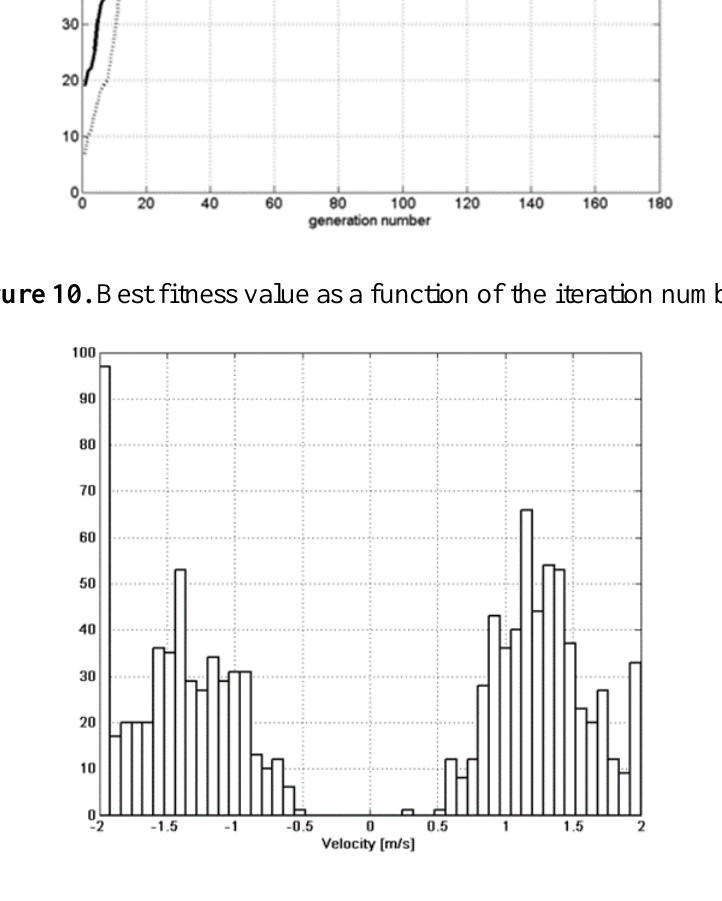
Figure 11. Velocity distribution ( GA results) for all performed